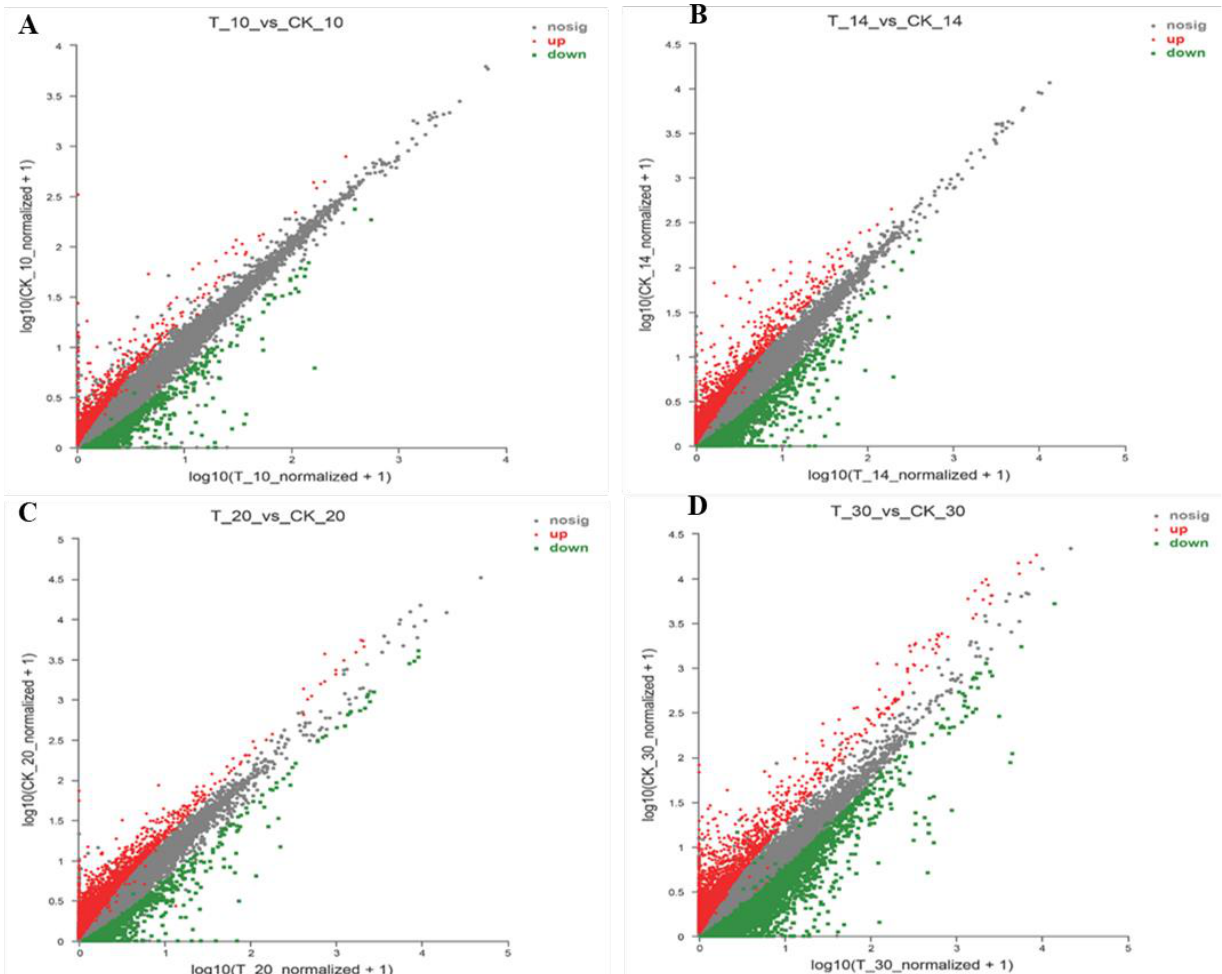
Figure 10. Volcano plots of DEGs in green versus red sectors. Data for all genes are plotted as log10 fold change (FC) versus the –log10 of raw p-value (pval). ( A ) Group T10 vs. CK10, ( B ) Group T14 vs. CK14, ( C ) Group T20 vs. CK20, and (D ) Group T30 vs. CK30. Points outside the gray area indicate >100-fold-differences in expression. Green points indicate down-regulated genes and red points indicate up-regulated genes in each contrast, detail given in Supplementary file S1, sheet 3 (Table S1).